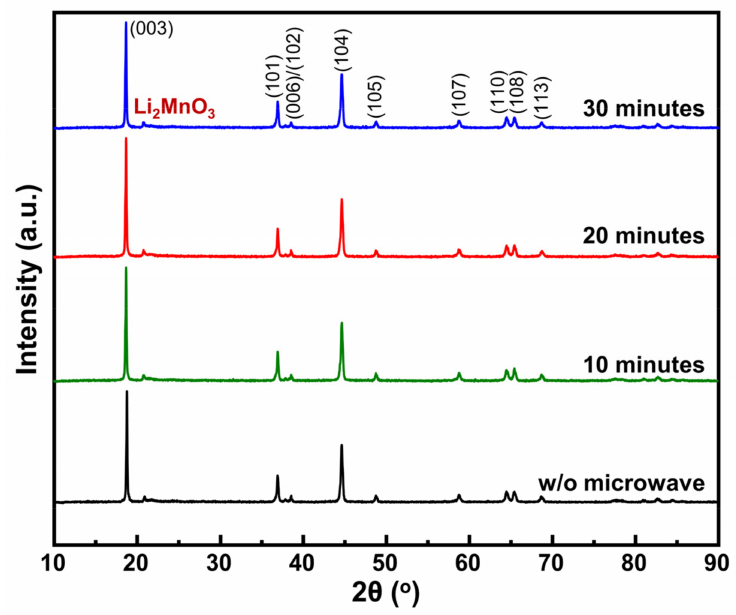
Figure 1. XRD patterns for LNCM with different microwave irradiation times: without microwave, 10 min, 20 min, and 30 min.